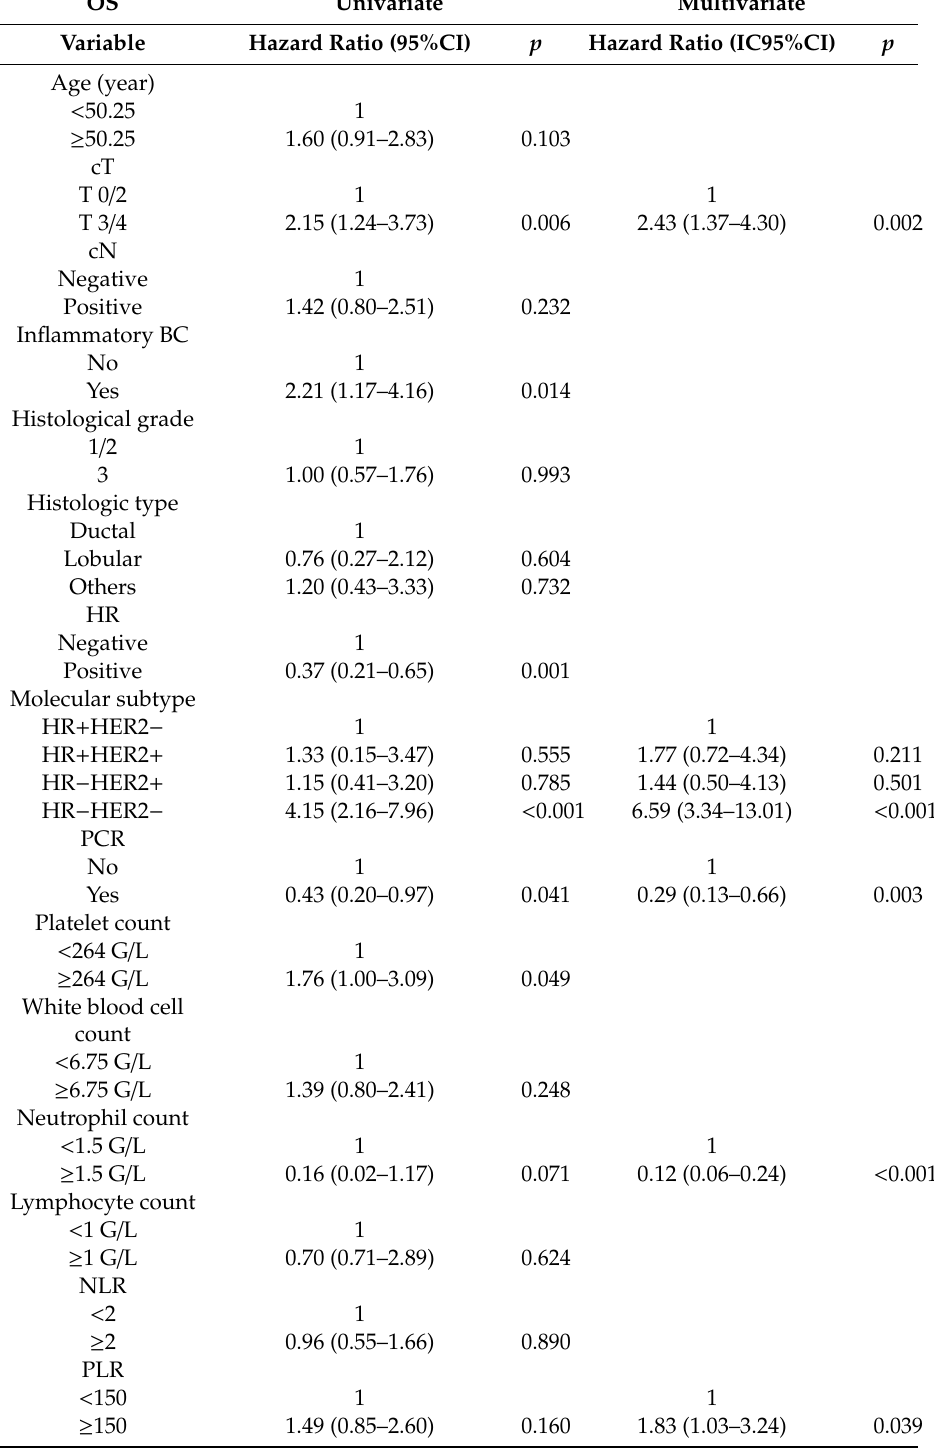
Table 4. Univariate and multivariate logistic regression of prognostic factors for overall survival (OS). OS Univariate Multivariate Variable Hazard Ratio